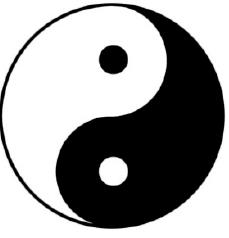
Figure 2. Yin Yang—symbol resource from: https://search.creativecommons.org/photos/dda8fdd9-f083-4546-bf9b-c5f44ba59dff (accessed on 25 March 2021).